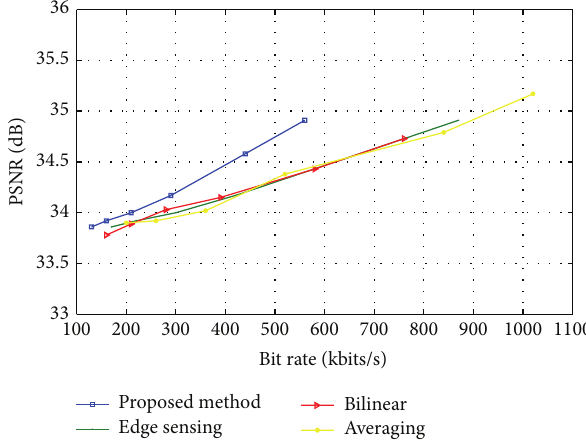
Figure 9: PSNR vis-a-vis bit-rates when two descriptions are lost (Foreman